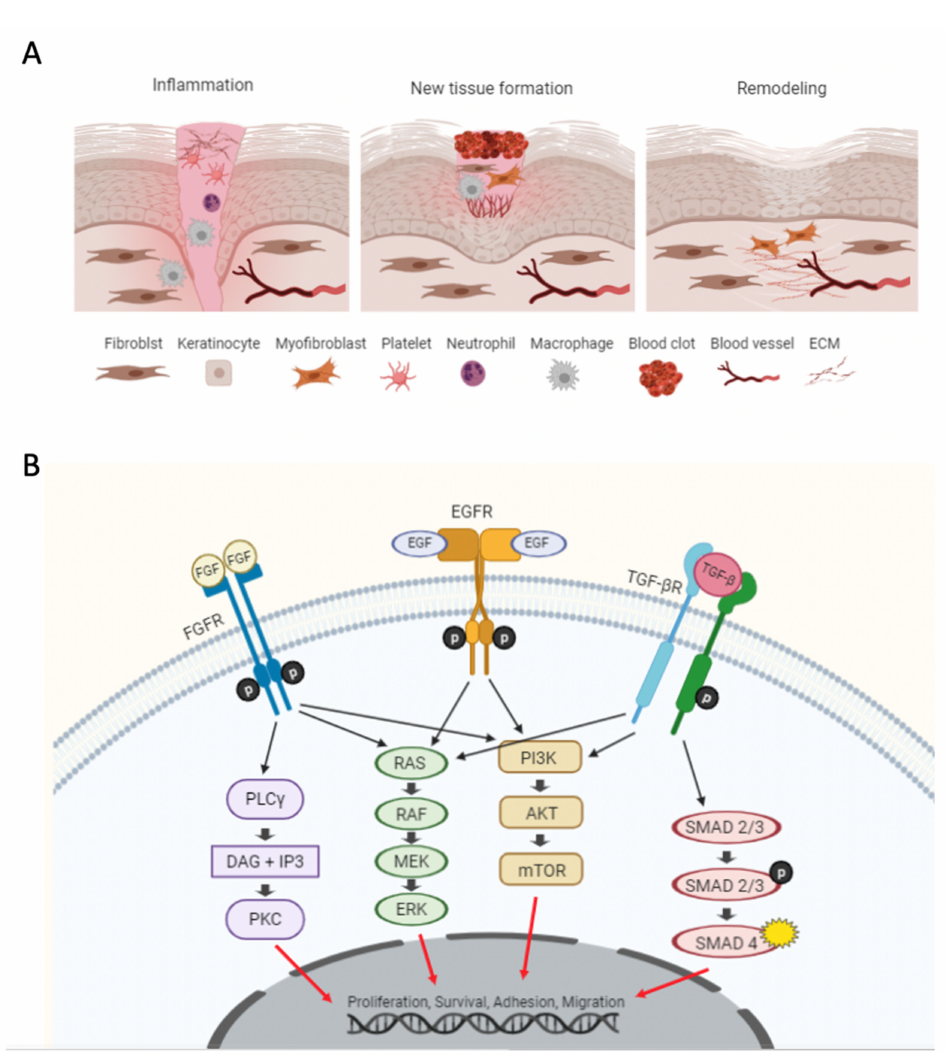
Figure 1. ( A ) Overview of the cellular processes during the three wound healing stages. ( B ) Schematic representation of pathways involved in wound healing, including receptors for fibroblast growth factors (FGFs), epidermal growth factors (EGFs), and transforming growth factor β (TGF- β